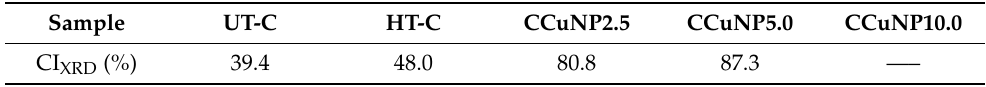
Table 1. Crystallinity index estimated from XRD